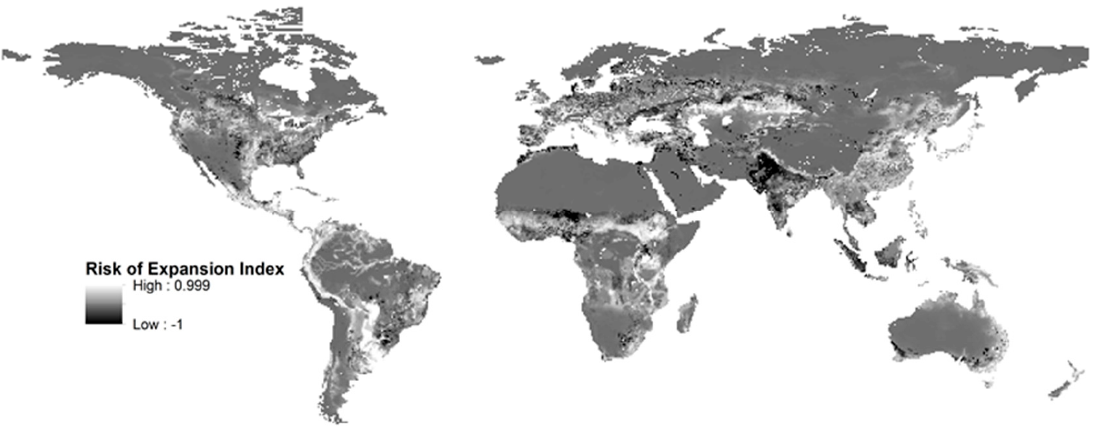
Figure 1. Risk of agricultural expansion index, representing the overlay of agricultural suitability of soil and global croplands database.